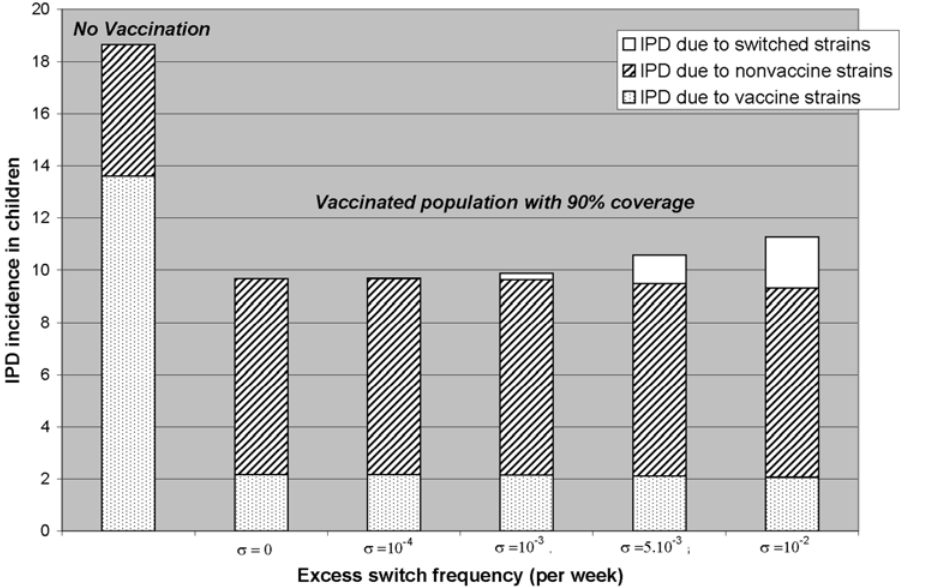
Figure 3. Invasive Pneumococcal Disease (IPD) incidence in children , 2 years old (per 100,000 children, per year) 5 years after the introduction of a conjugate vaccine, as a function of the frequency of capsular switch selected in vaccinated individuals, for a 90% vaccination coverage. The origin of the cases (vaccine strains, non-vaccine strains, switched strains) is specified, and the expected incidence without vaccination is also depicted as a reference.